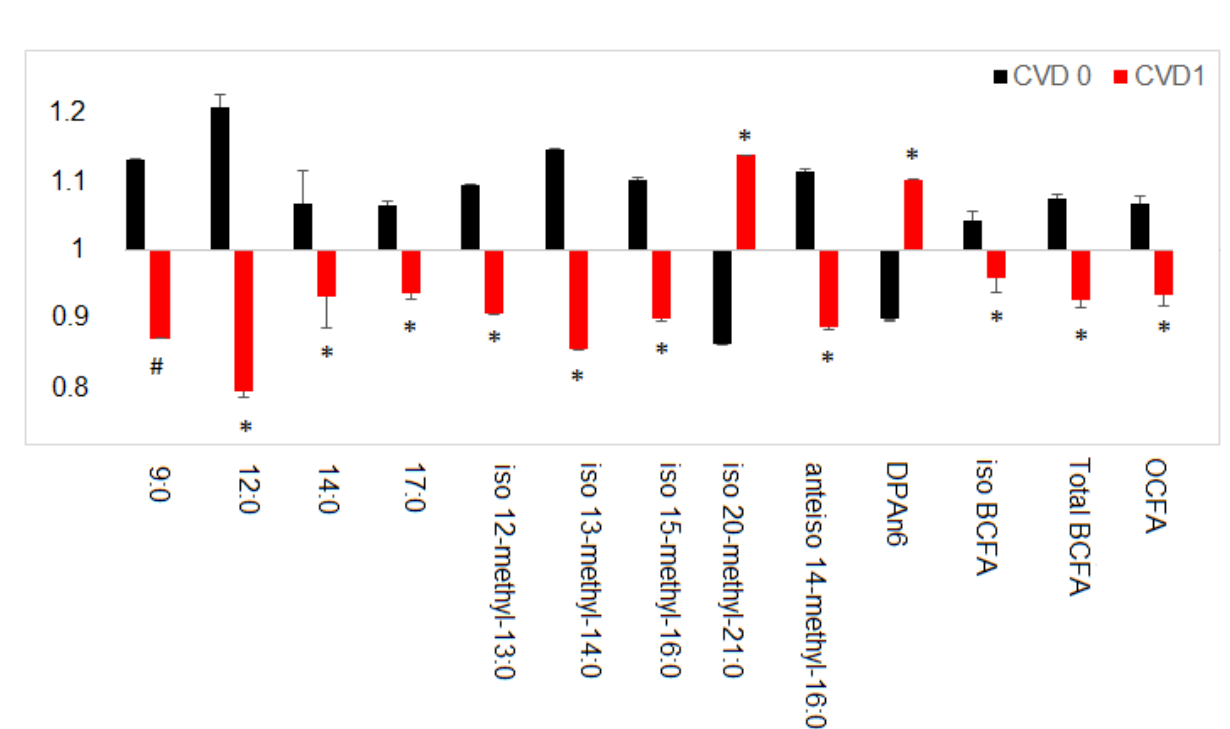
Figure 4. Normalized FA differences in Tx patients with (CVD 1) or without (CVD 0) cardiovascular disease. Data are presented as mean ± SEM. * p < 0.05; # p < 0.001 indicates statistically significant difference compared to CVD 0. BCFA-branched chain fatty acids; DPA n6-docosapentaenoic acid n6; OCFA-odd chain fatty